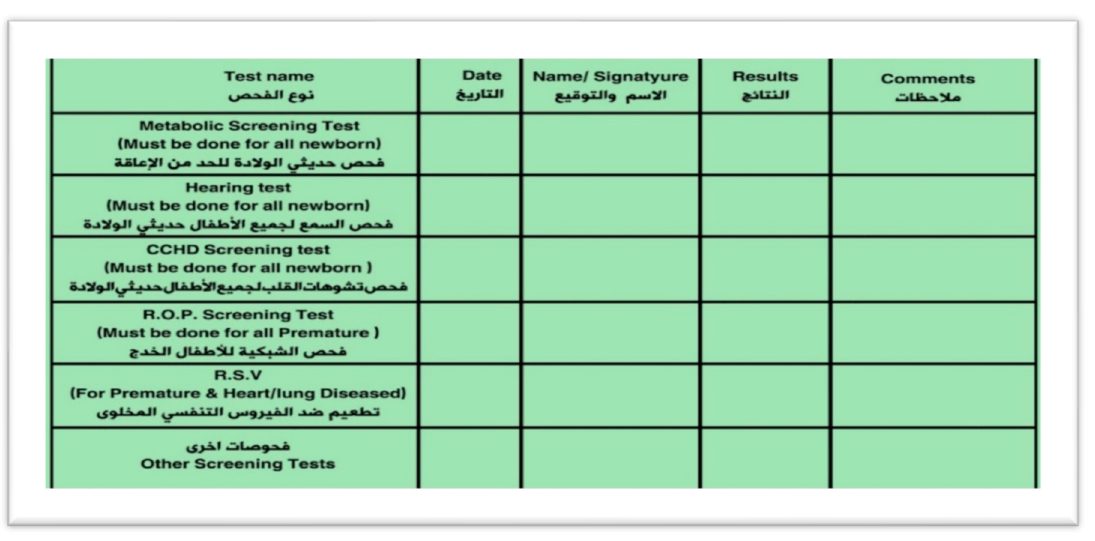
Figure 1. Documenting CCHD screening result in the baby’s vaccination card.